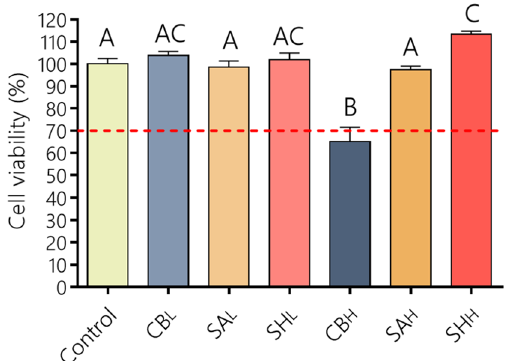
Figure 1. Effect of PE L and PE H on CV% of HDF cells after 24 h of treatment. The CV% was calculated from Eq. (1). Values are expressed as the means ± their standard errors (n = 8). Differences between the treatments were evaluated with ANOVA and Tukey’s post-test (p < 0.05), with different capital letters above the bars indicating significant differences. The dotted line determines the cell viability limit allowed by ISO 10993 5 (CV ≥ 70%). Plotted with GraphPad Prism v.7.00 software (GraphPad, USA, https:// www. graph pad.